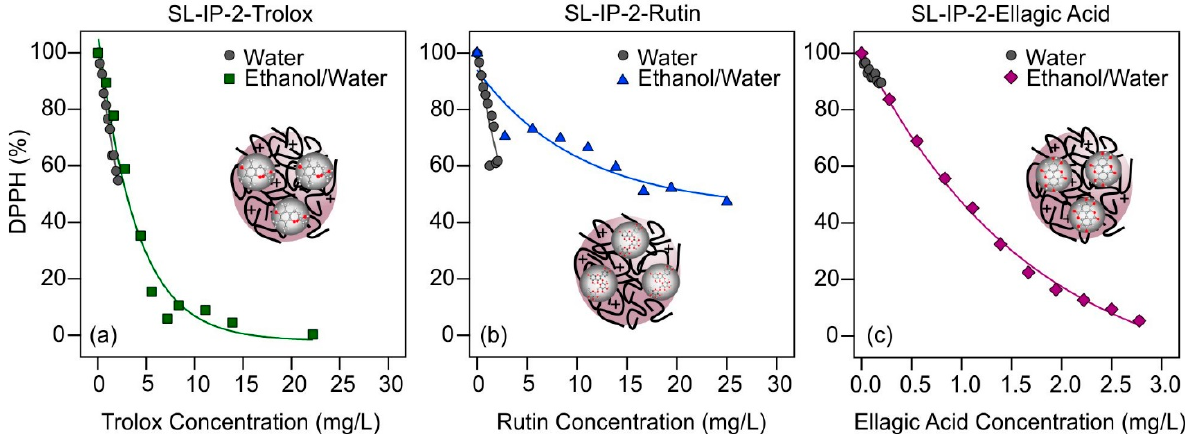
Figure 4. DPPH scavenging activity of SL-IP-2-trolox ( a ); SL-IP-2-rutin ( b ); and SL-IP-2-ellagic acid ( c ) as a function of the actual antioxidant concentrations using different solvents (water (gray circles) and ethanol/water (green squares, blue triangles, and purple diamonds, respectively,)) for stock dispersion preparation. The relative amount of the antioxidants was always 100 mg per 1 g of SL-IP-2. The solid lines are mathematical functions used to calculate the EC 50 values. The schemes in inset illustrate the possible antioxidant adsorption on the surface of the polymer coated particles.